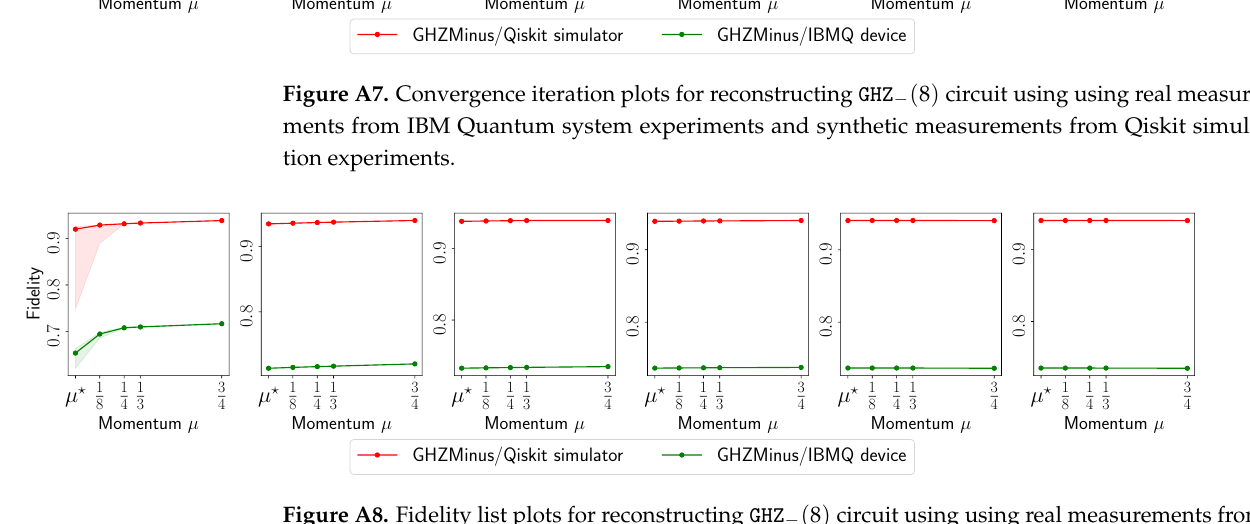
( 8 ) circuit using using real measurements from −